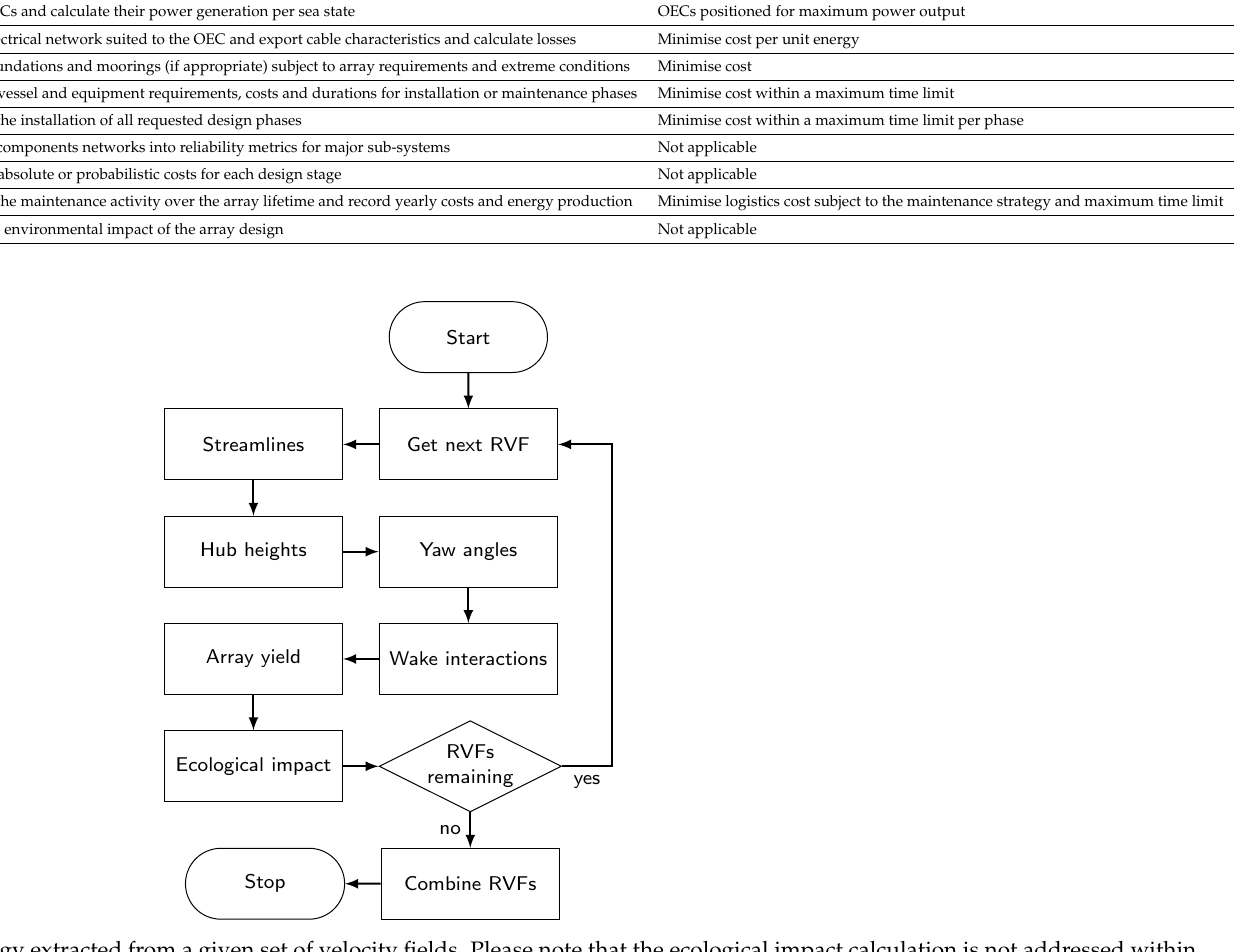
Figure 2. Process for determining the energy extracted from a given set of velocity fields. Please note that the ecological impact calculation is not addressed within this